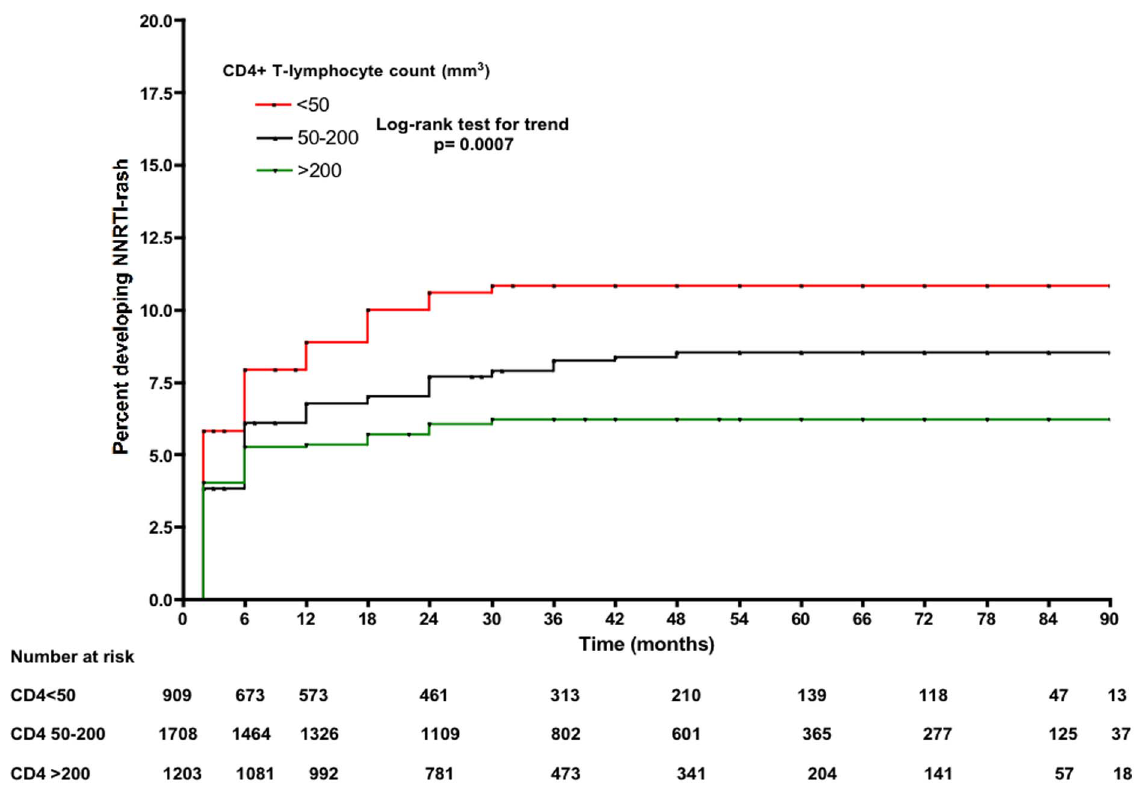
Figure 2. Kaplan-Meier estimates of risk for NNRTI-related skin rash according to CD4 count at baseline.